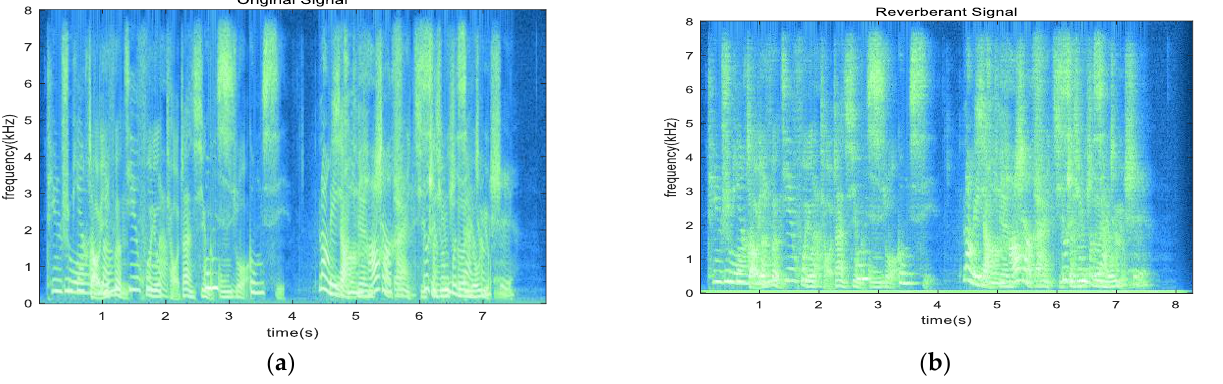
Figure 2. The TF spectrums of different signals: ( a ) the original speech signal; ( b ) the recorded signal with 𝑇 60 = 300 ms .